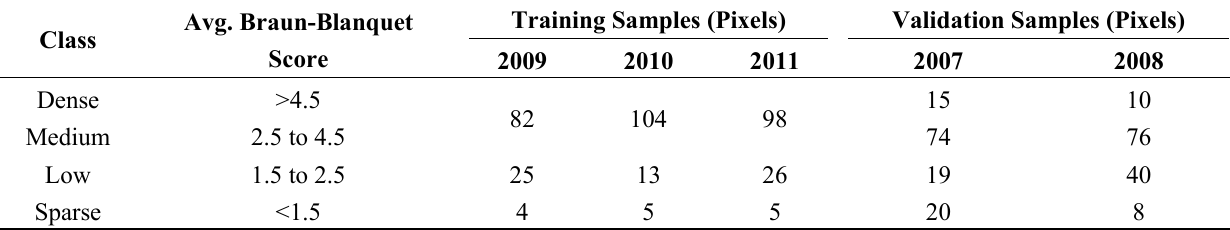
Table 2. Summary of seagrass cover classes employed in this study, including the number of pixels used for training and validation. Pixels representing medium and dense seagrass cover were grouped for selection of training